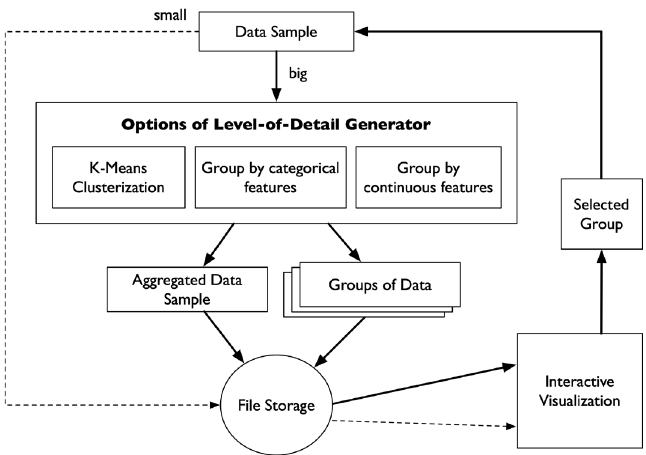
Figure 1. Structure of the Level-of-Detail